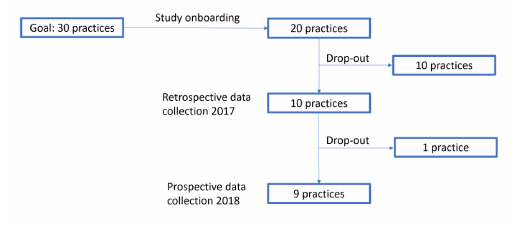
Figure S1: Flow-chart showing the recruitment process of general primary care practices.